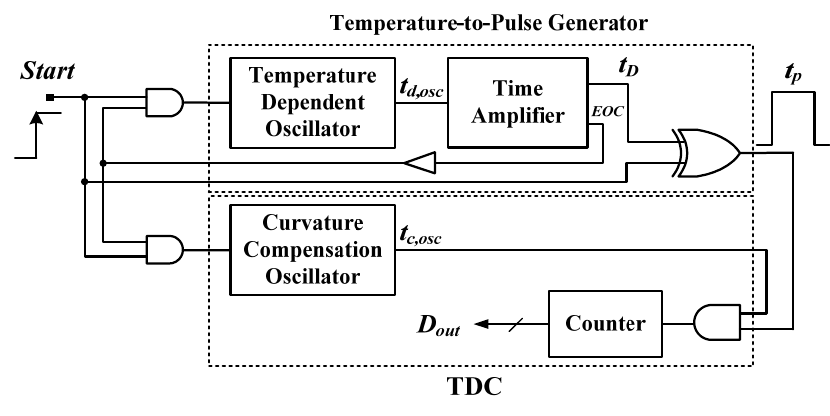
Figure 5. Block diagram of the proposed smart temperature